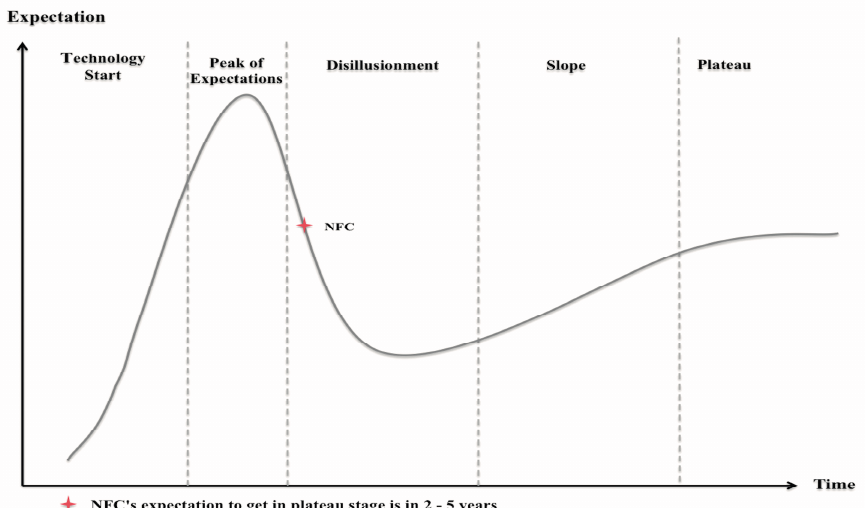
Figure 2. NFC technology in the Hype Cycle curve (source: authors’ elaboration based on [16]).